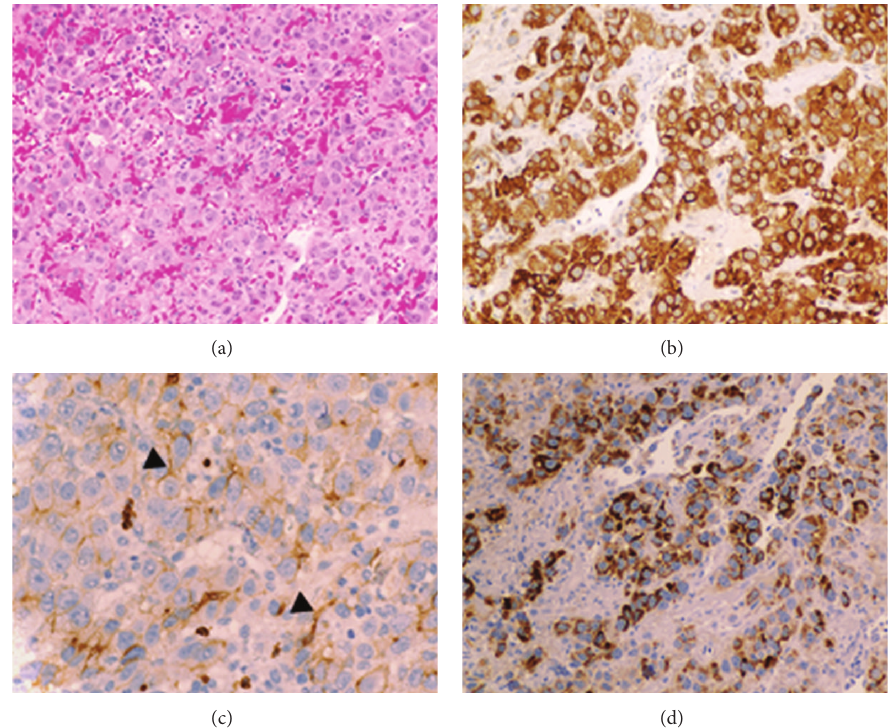
Figure 2: (a) (H&E, 20 × ) Poorly differentiated hepatocellular carcinoma composed of large epithelial cells with abundant pink cytoplasm and central atypical nuclei. (b) (H&E, 20 × ) Glypican-3 immunostain positive (brown chromogen). (c) (H&E, 40 × ) Polyclonal carcinoembryonic antigen immunostain highlights a positive canalicular pattern (arrowheads). (d) (H&E, 40 × ) Hepatocyte paraffin-1 immunostain (brown chromogen).